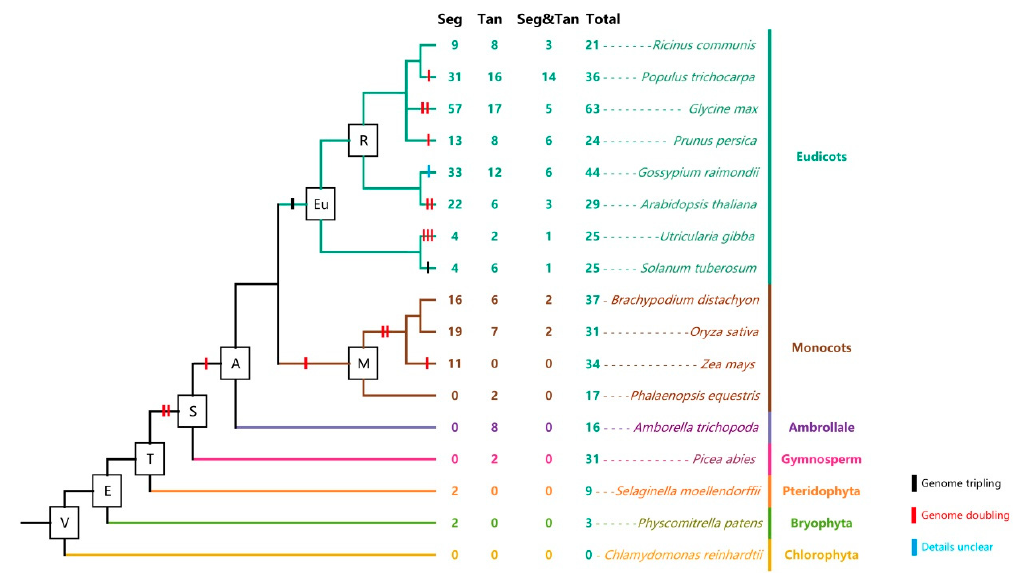
Figure 5. Duplication events of Aux/IAAs in the plant kingdom. This phylogenetic tree was decorated with whole-genome duplication events (Available online: http://chibba.pgml.uga.edu/ duplication/index/files) and the number of genes derived from segmental duplication, tandem duplication, and both events. The phylogenetic tree of 17 species was from the Tree of Life Web Project (Available online: http://www.tolweb.org/Green_plants). Seg: segmental duplication; Tan: tandem duplication; Seg&Tan: genes belonging both to segmental duplication and tandem duplication; Total: total Aux/IAA gene number in the